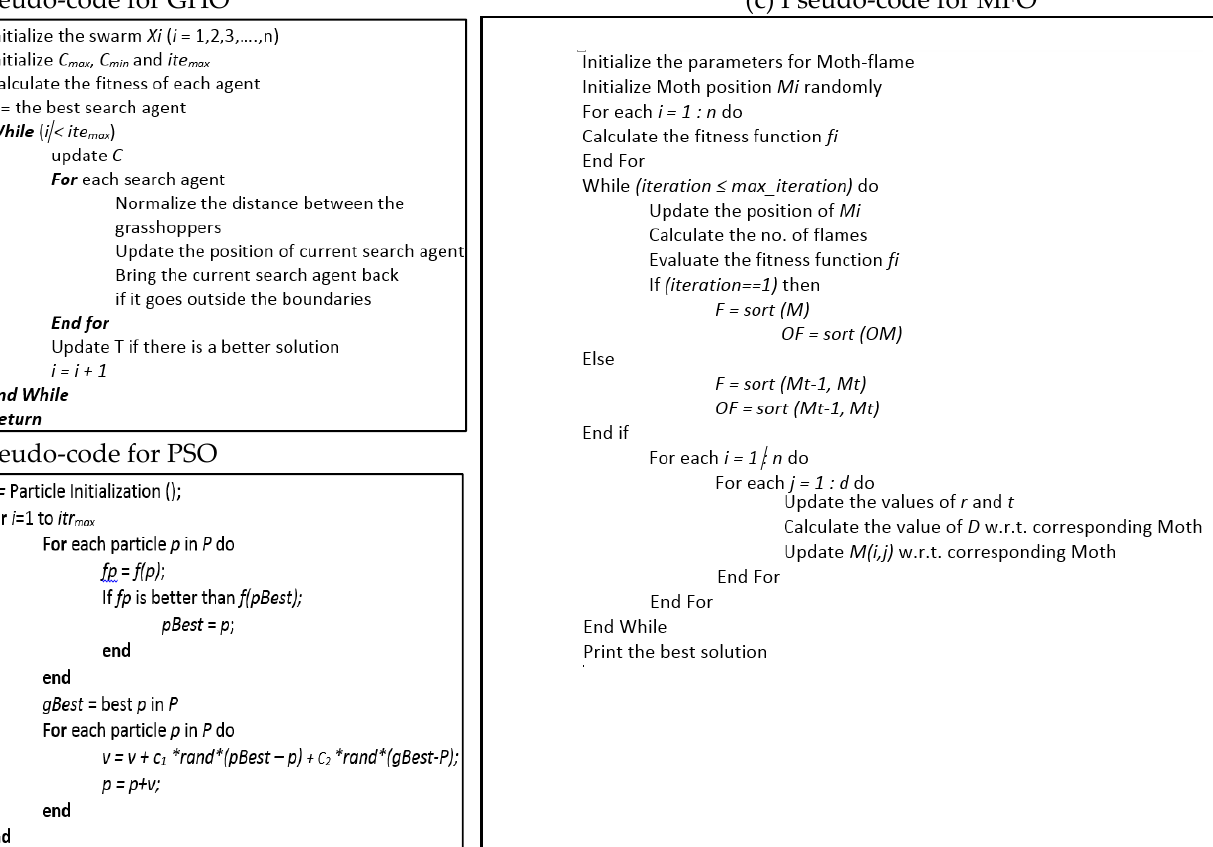
Figure 5. Pseudo-code ( a ) GHO, ( b ) PSO, ( c ) MFO.